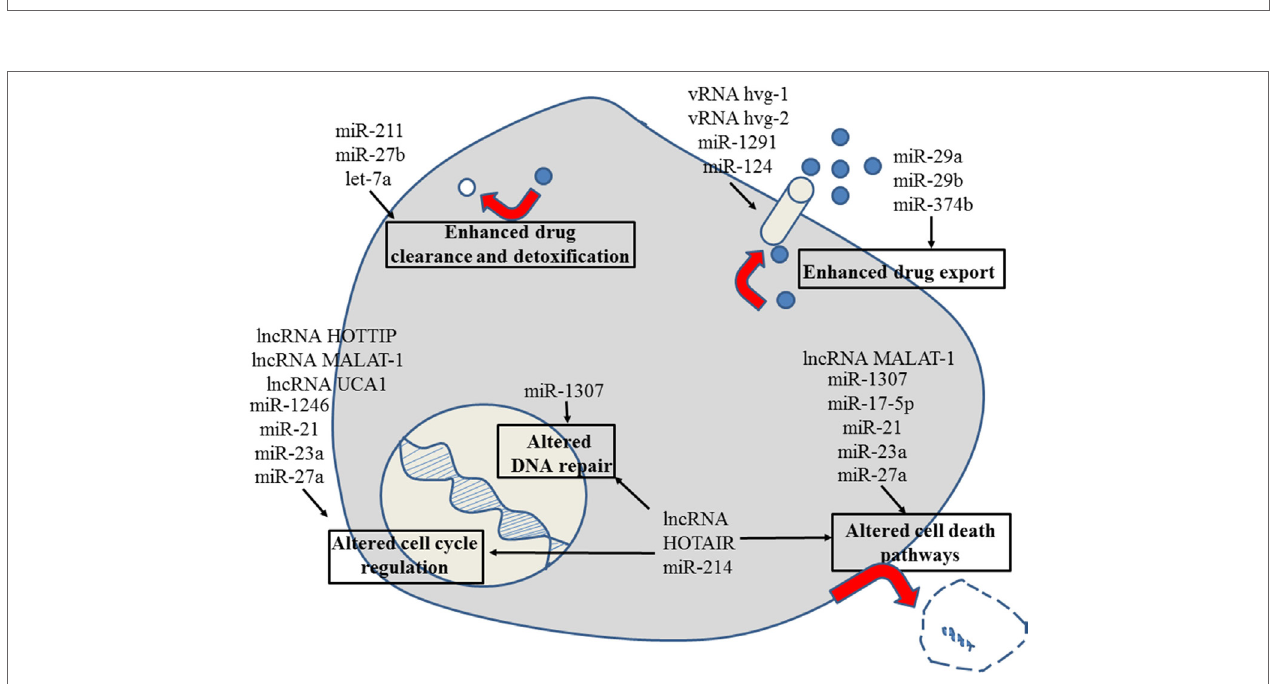
FiGURe 4 | Role of non-coding RNAs for the different reasons that can cause resistance to anticancer drugs in colon and colorectal cancer. For details about target genes and regulated protein expression by the non-coding RNAs, see